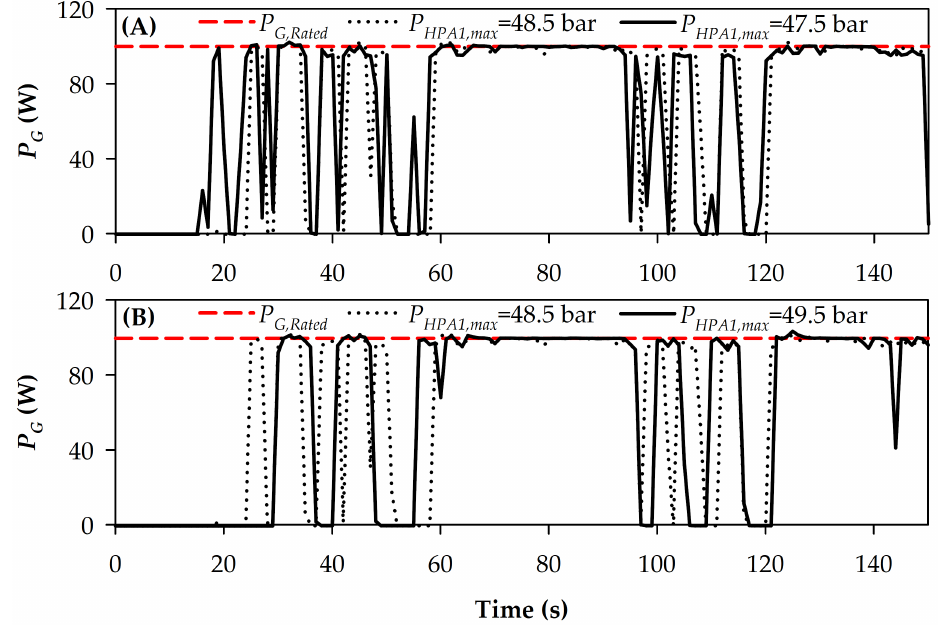
Figure 25. The profiles of the generated electrical power from the improved HPTO unit for different P HPA 1, max cases. ( A ) P HPA 1, max = 47.5 bar; ( B ) P HPA 1, max = 49.5